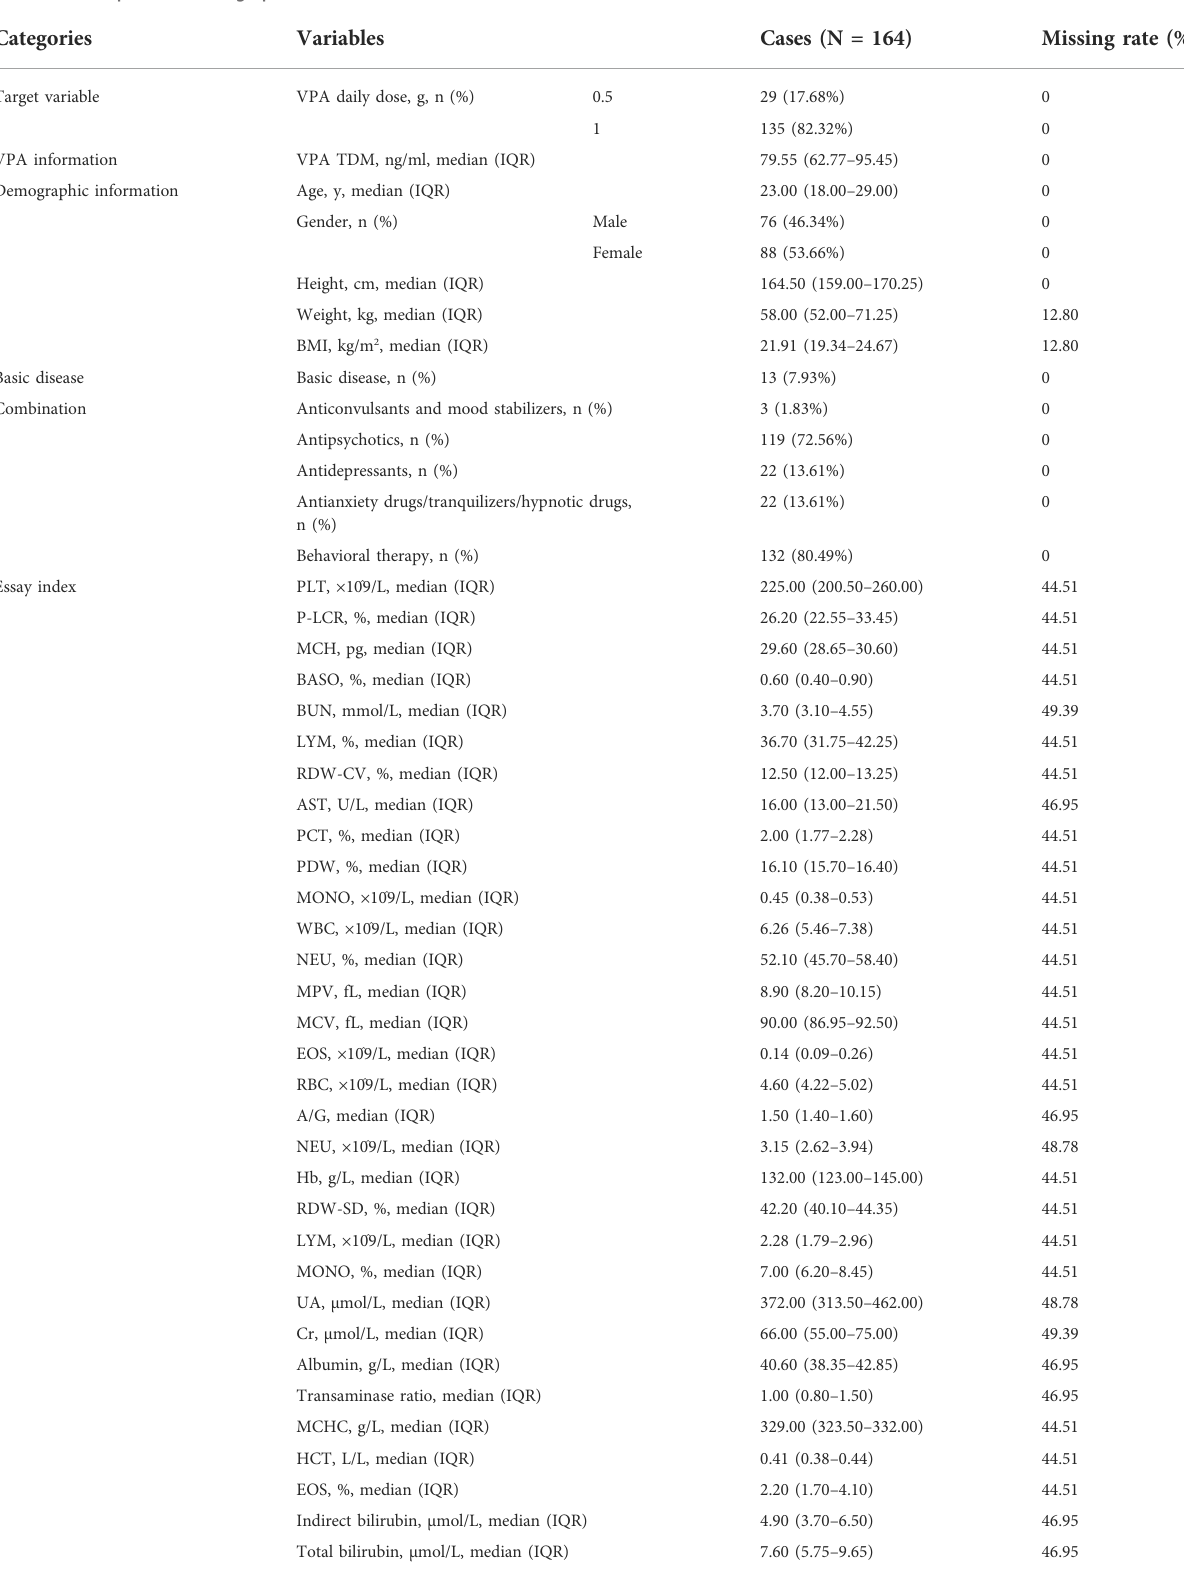
TABLE 1 Description of demographic and clinical